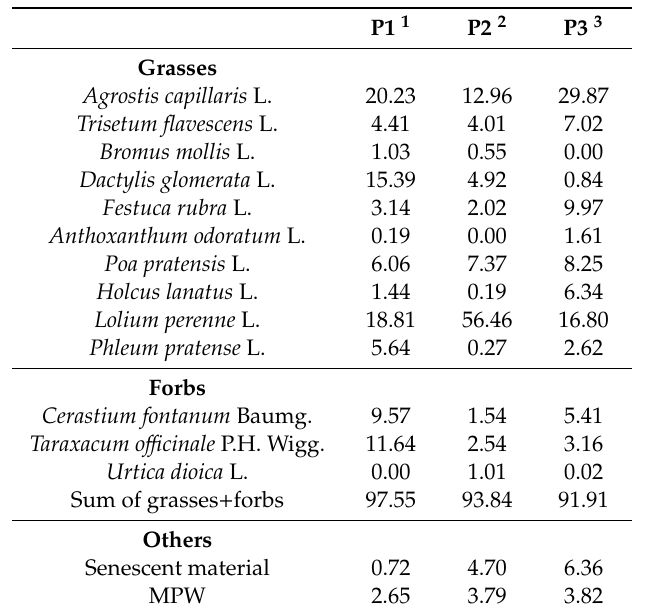
Table2. Botanicalcomposition(percentageofdrymatter)andmeanplantweight(MPW)(dimensionless) phenological stage of the permanent grassland in the three periods of the